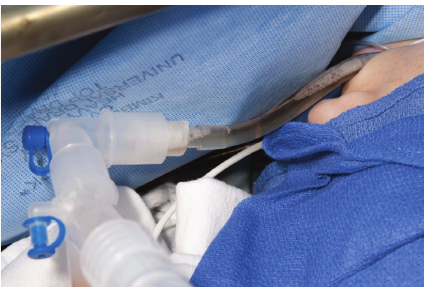
Figure 3: Transesophageal echocardiography: midesophageal 4 chamber view with emphasis in tricuspid valve at 34 ∘ . Continuous wave Doppler assessment of tricuspid valve regurgitation used to calculate right ventricular systolic pressure (RVSP). Note peak pressure gradient of 92 mm Hg.